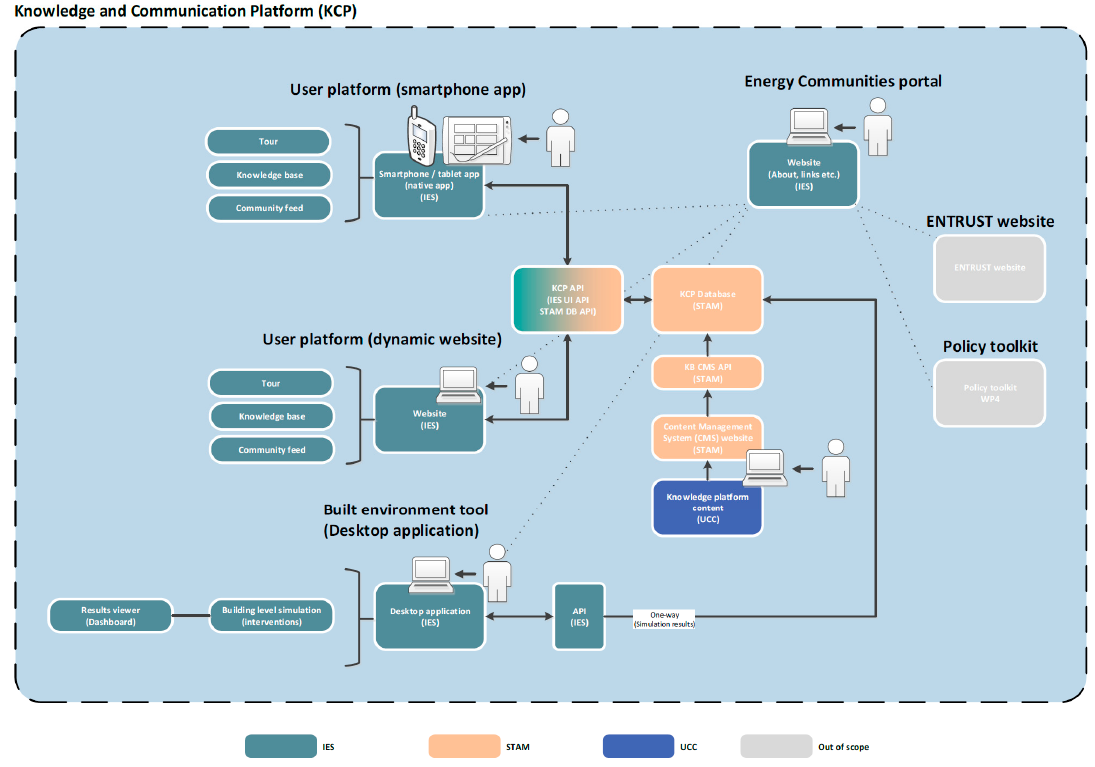
Figure A1. Overview of the ENTRUST knowledge and communication platform